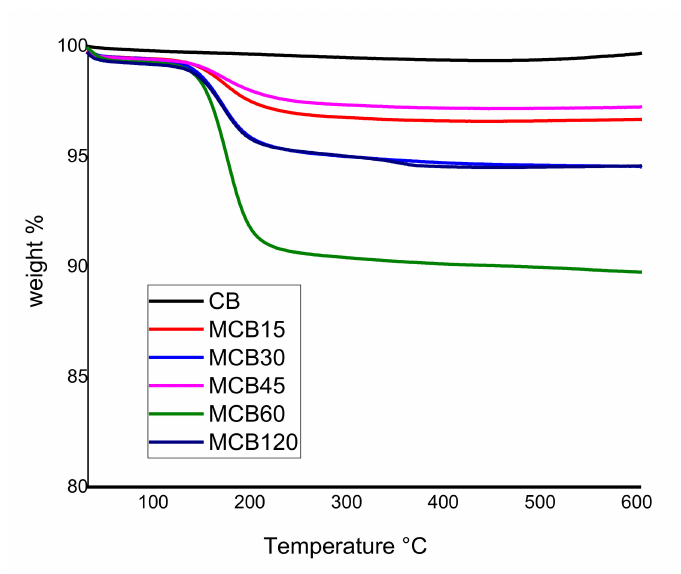
Figure 1. Thermogravimetric analysis of the carbon black and modified carbon